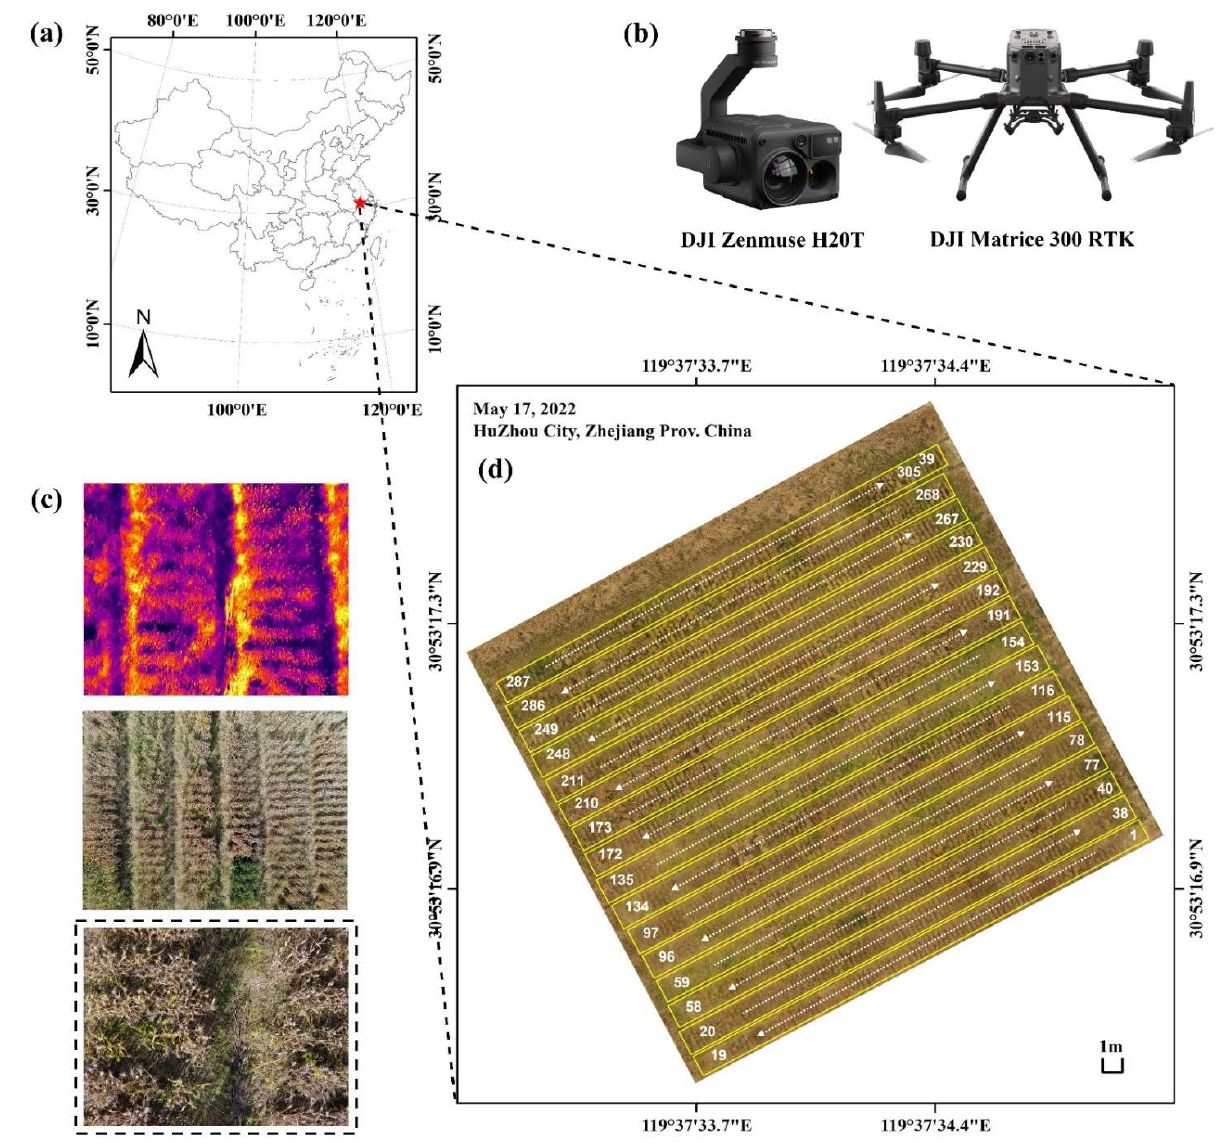
Figure 2. Experimental site and design. ( a ) Location of the e xperimental site; ( b ) UAV and sensor; ( c ) three types of images captured by the sensor; ( d ) plot design of the experimental site.